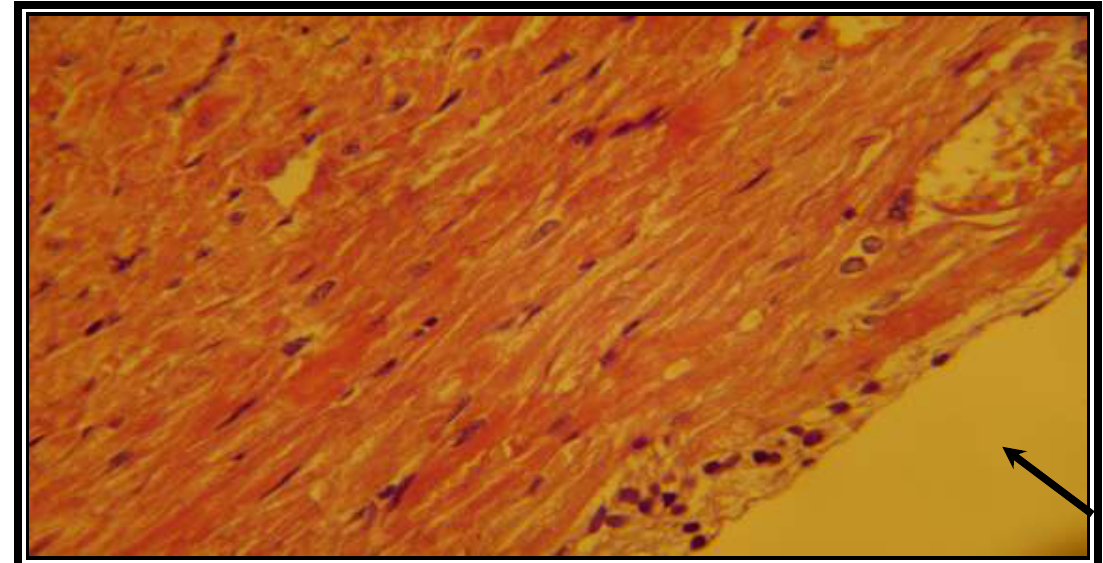
Figure (5) Histological section in heart ofH2O2 treated rats. Note: inflammatory cell infiltration in epicardium (  ) H & E 40X.